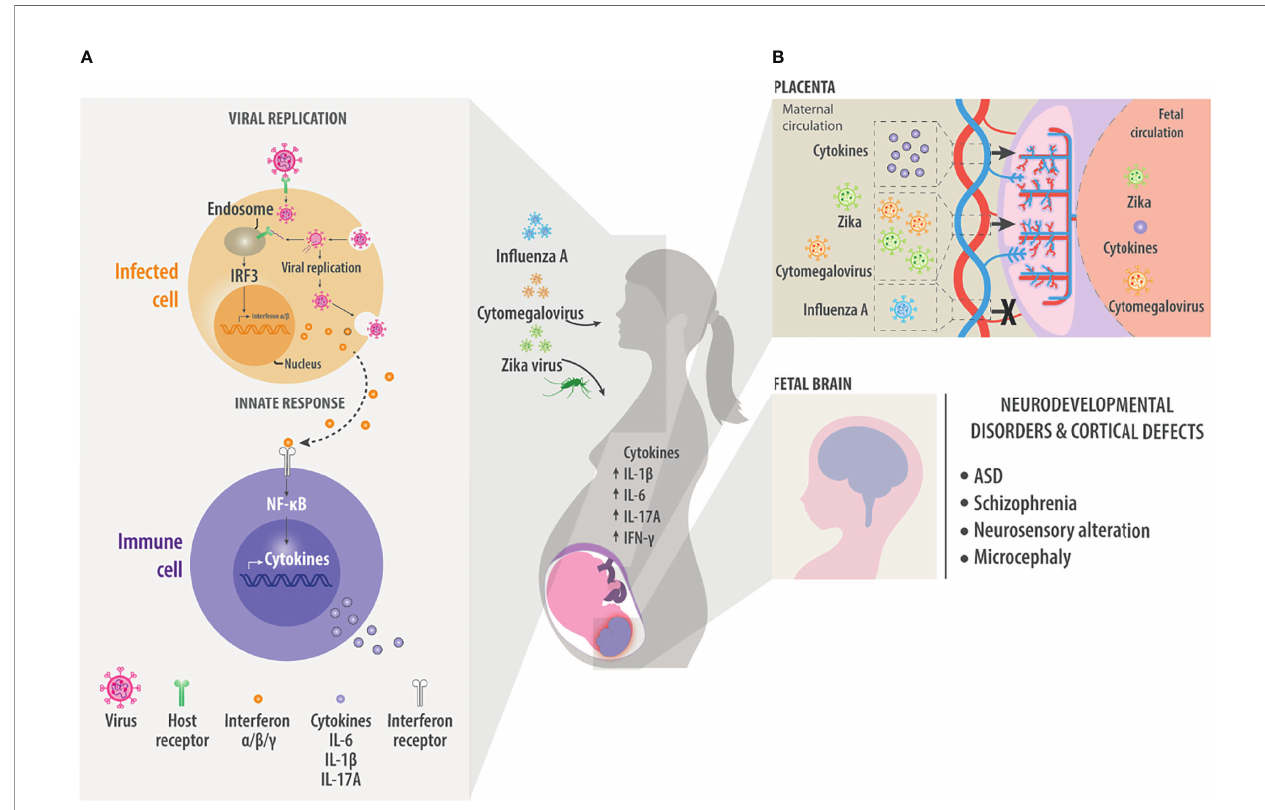
FIGURE 1 | Maternal viral infection. As a result of maternal viral infection, immune responses generate pro-in fl ammatory cytokines such as IL-1 b , IL-6, and IL-17A. These cross the placenta and generate neuroin fl ammation in the fetal brain. (A) During viral infection, molecules on the viral surface are recognized and trigger a cascade of events in the infected cell. Host receptors recognize viral molecules or nucleic acids and initiate a signaling cascade that ends with the nuclear translocation of transcription factors such as interferon regulatory factor 3 (IRF3), which induce the synthesis of type I interferons a and b , which are ultimately released into the extracellular environment. There the interferons are detected by cells of the innate immune system. Innate immune system cells, such as macrophages or dendritic cells, recognize pathogen- associated molecular patterns (PAMPs) and damage-associated molecular patterns (DAMPs). They also respond to cytokines such as interferons to activate signaling pathways via NF- k B to generate pro-in fl ammatory cytokines such as IL-6 and IL-1 b . These factors trigger in fl ammation and recruit more cells to inhibit viral replication or kill infected cells. (B) Maternal infection by the In fl uenza A, Cytomegalovirus or Zika virus generates an increase in maternal pro-in fl ammatory cytokines that can reach the fetal circulation through the placenta. In the same way, viruses such as Cytomegalovirus or Zika also cross the placenta and directly affect the fetal brain. In the fetal brain, the presence of pro-in fl ammatory cytokines or viruses can result in neurodevelopmental disorders and defects in the formation of the cerebral cortex, manifesting effects such as ASD, Schizophrenia, neurosensory alteration or